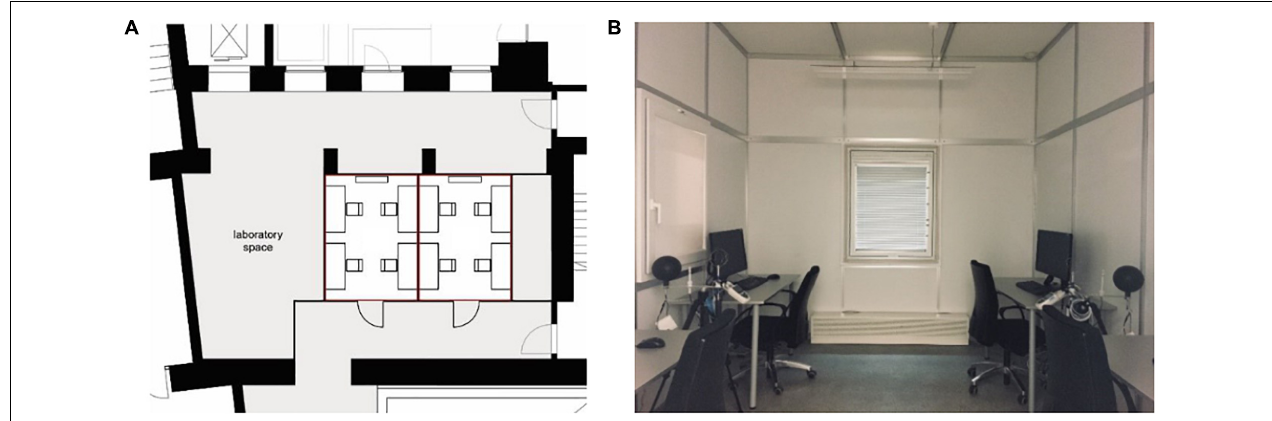
FIGURE 1 | Schematic plan (including the position of low-velocity supply air diffusers in each room) (A) and view (B) of the mock-up office spaces within the larger laboratory space.